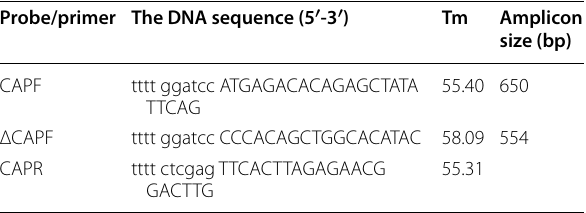
The lowercase letters are protective bases and restriction sites, respectively